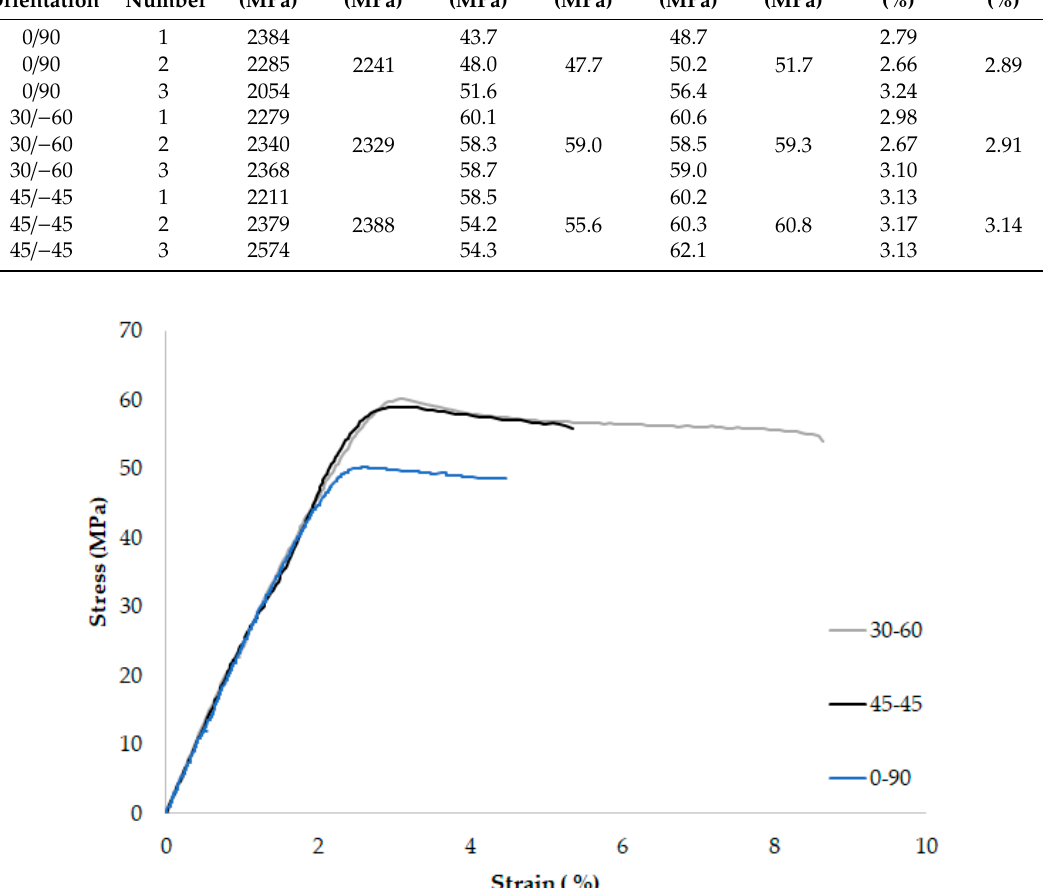
Figure 2. Examples of tensile curves for the three raster orientations (engineering stress-engineering strain).